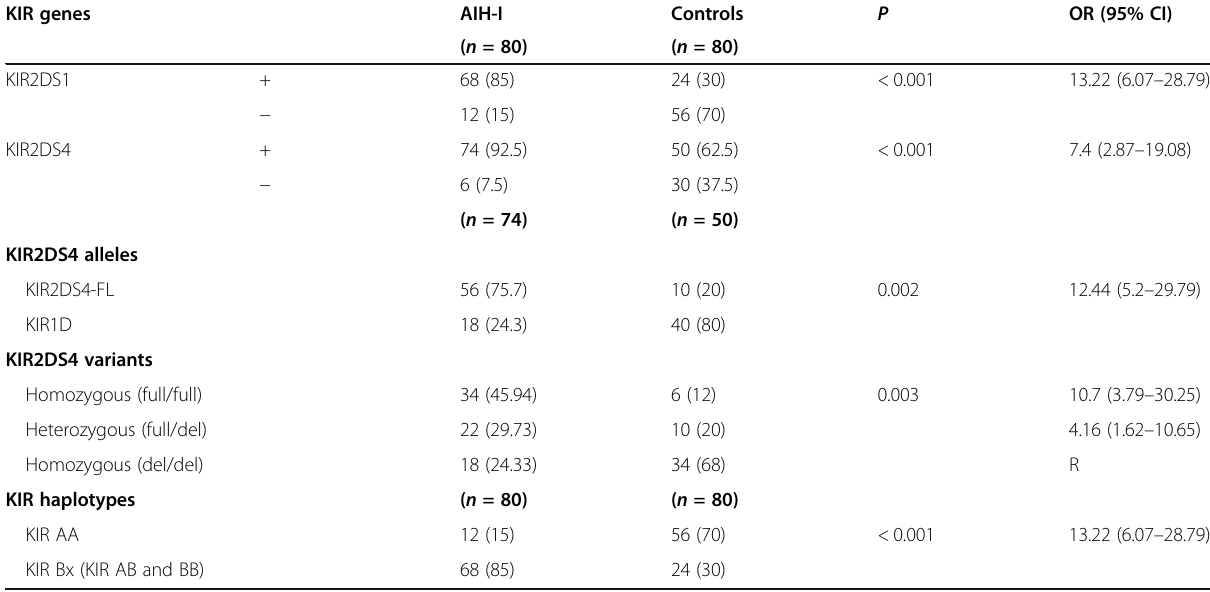
Table 2 KIR frequencies in type I AIH and healthy individuals KIR genes